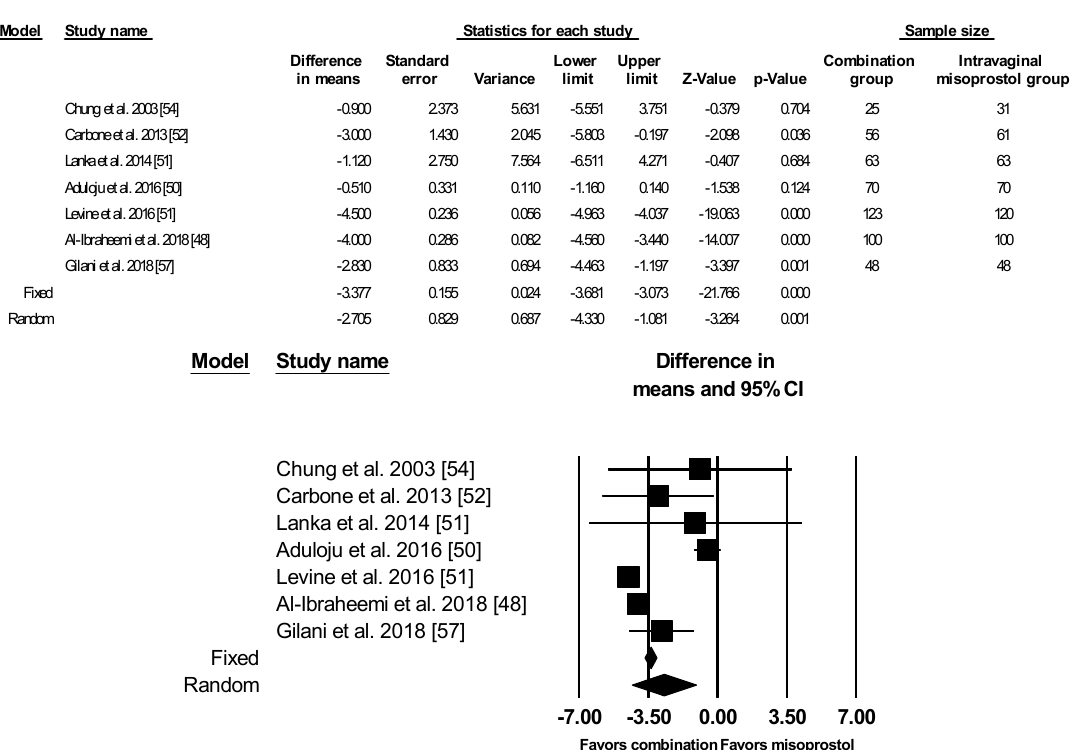
Figure 3. Comparison 2: Combination of intracervical Foley catheter and intravaginal misoprostol versus intravaginal misoprostol alone for cervical ripening, Outcome 2: Time to delivery in sample size > 200. Heterogeneity: Tau 2 = 0.056; ꭓ 2 = 1.821 df = 1 ( p = 0.177); I 2 = 45.089%. Test for overall effect (fixed): Z = − 23.167 ( p = 0.000)